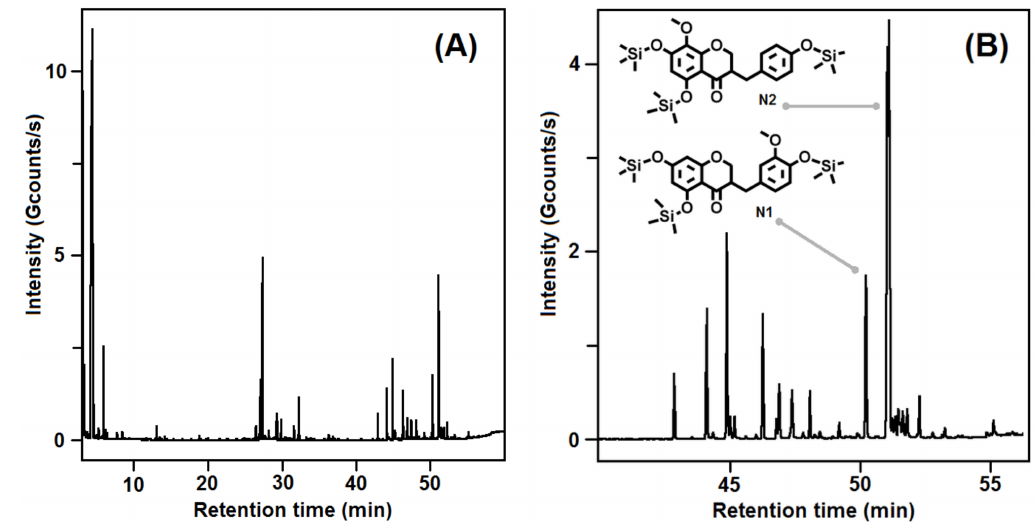
Figure 3. Gas chromatography–mass spectrometry (GC–MS) analysis of the hydroalcoholic extract of L. comosa bulbs: ( A ) chromatographic profile (total ion current, TIC); ( B ) detail of the chromatogram including indication of the peaks of the two silyl-functionalized homoisoflavones N1 and N2 .